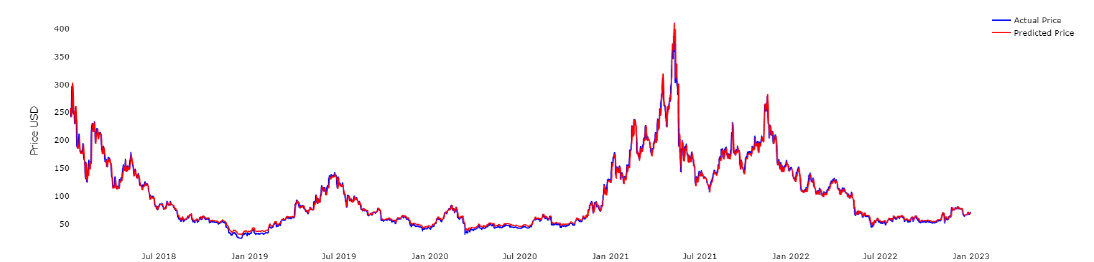
Figure 18. LTC—actual and predicted results using the GRU model.